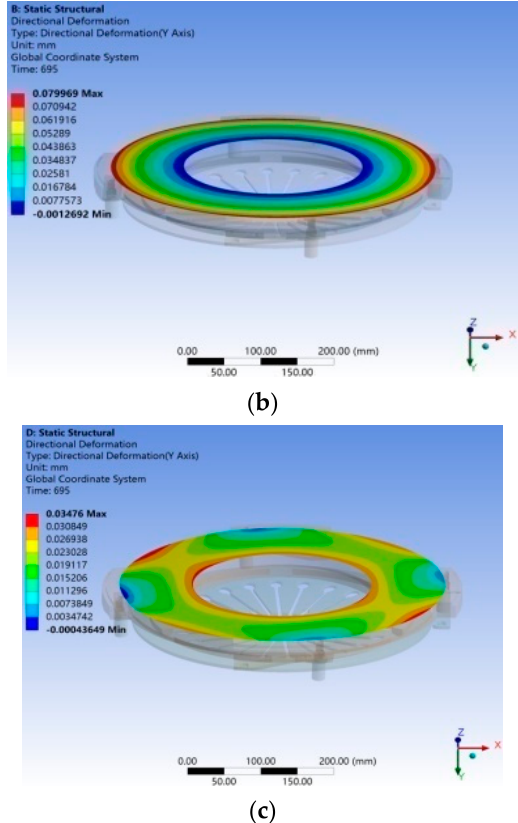
Figure 6. The temperature field ( a ), deformation field under constraint condition 1 ( b ), and deformation field under constraint condition 2 ( c ) of pressure plate at 695 s.